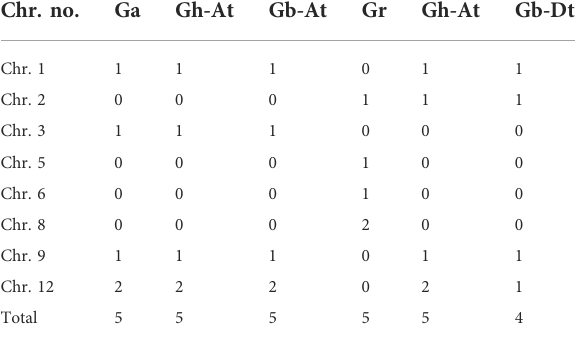
TABLE 1 Comparison of the chromosome harboring number of GADs from different genomes and subgenomes of four Gossypium (Ga, Gr, Gh, and Gb).